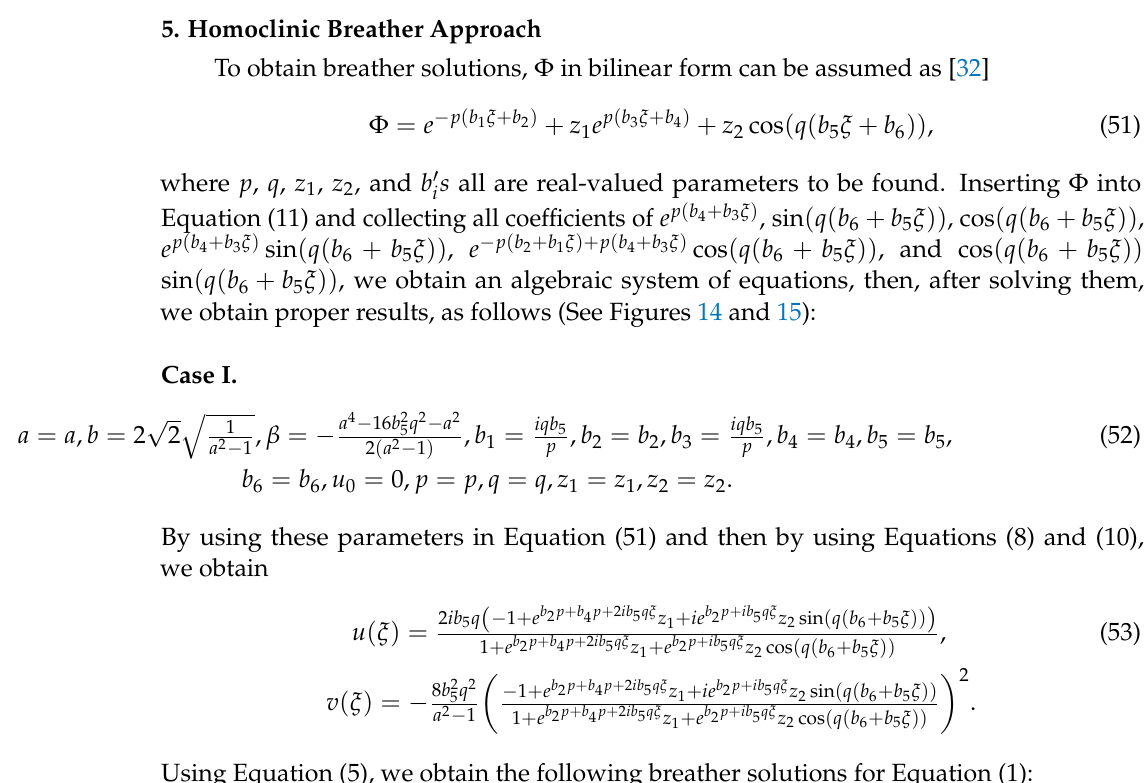
Figure 13. Represented three-dimensions in ( a ); contour in ( b ) and two-dimensions in ( c ), Graphical representation of n 44 ( x , t ) in Equation (50), for u 0 = 0.1, b 2 = − 5, b 4 = 5, b 5 = 3, b 6 = 10, z 0 = − 2, z 1 = 1, z 2 = 2, α = 0.9,